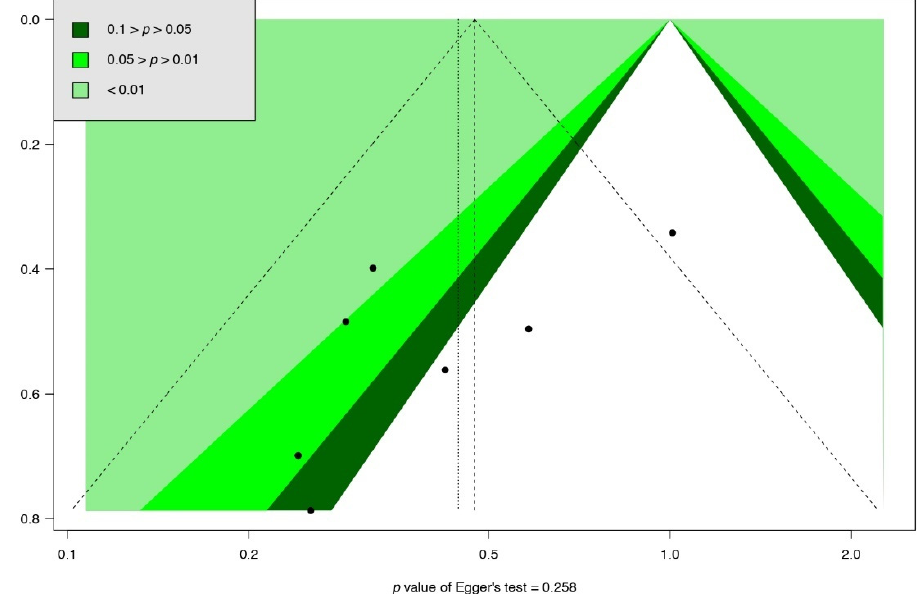
Figure A39. Comparison-adjusted funnel plot in outcome for overall complications.